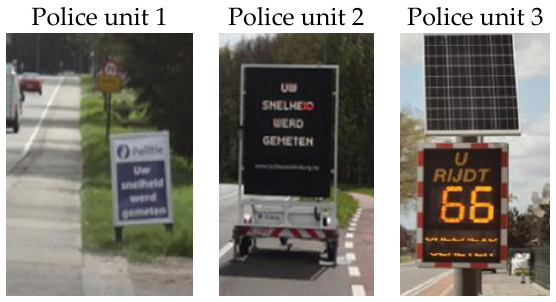
Figure 2. Used signage in the field experiment.